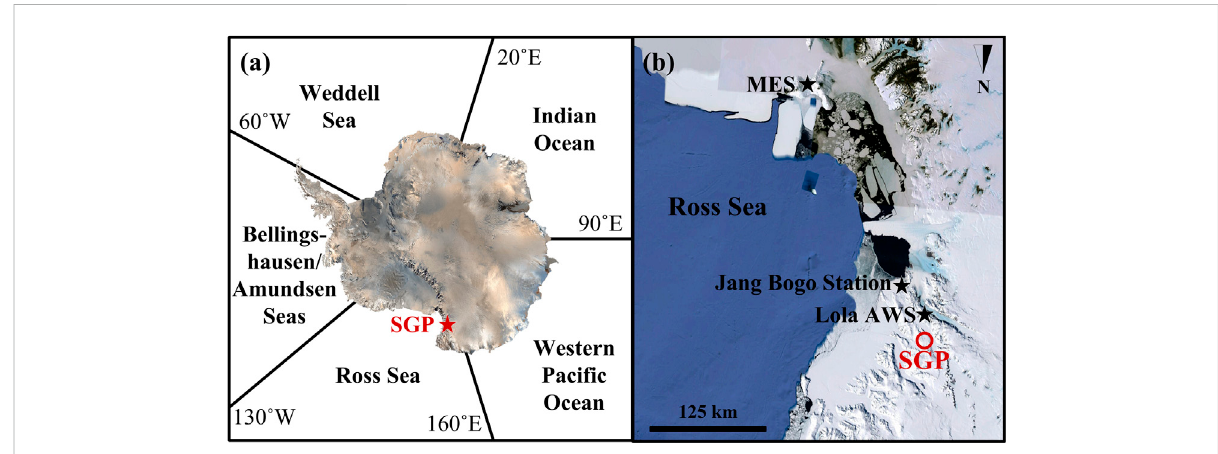
FIGURE 1 (A) Map of the Antarctic continent showing the drilling site on the Styx Glacier plateau (SGP), northern Victoria Land, East Antarctica, and fi ve oceanic sectors across the Southern Ocean, Weddell Sea (60 ˚ W – 20 ˚ E), Indian Ocean (20 – 90 ˚ E), Western Paci fi c Ocean (90 – 160 ˚ E), Ross Sea (160 ˚ E – 130 ˚ W),and Amundsen – BellingshausenSea(130 – 60 ˚ W),as de fi ned byParkinson(2019). (B) Enlarged scale of theRossSearegionshowing the SGP, the Korean Jang Bogo Station, an Italian automatic weather station (Lola AWS), and Mt. Erebus Saddle (MES; 77 ° 30.90 ′ S, 167 ° 40.59 ′ E, 1,600 m above the sea